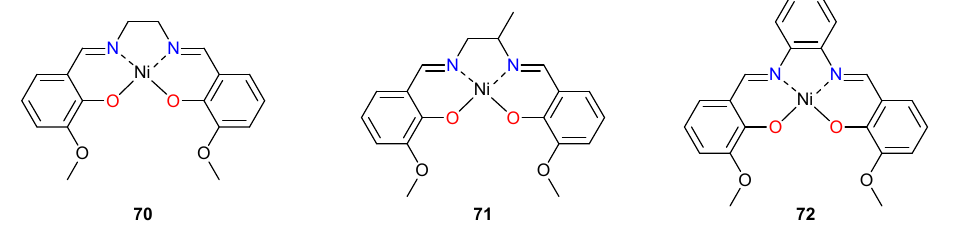
Figure 13. Ni salen complexes 70–72 [58].